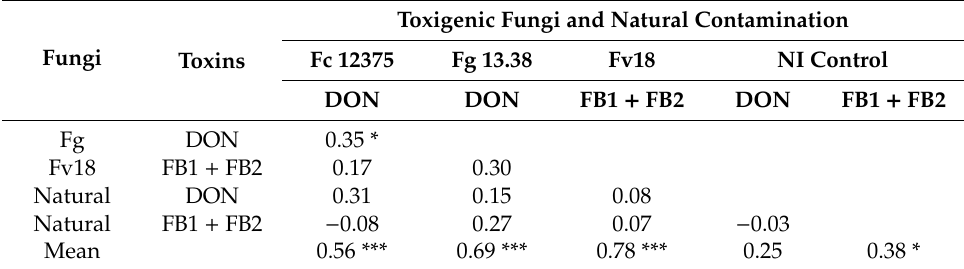
Table 10. Toxin contamination in KR tests 2010–2012, correlation analysis of Table 9. Toxigenic Fungi and Natural Contamination Fungi Toxins